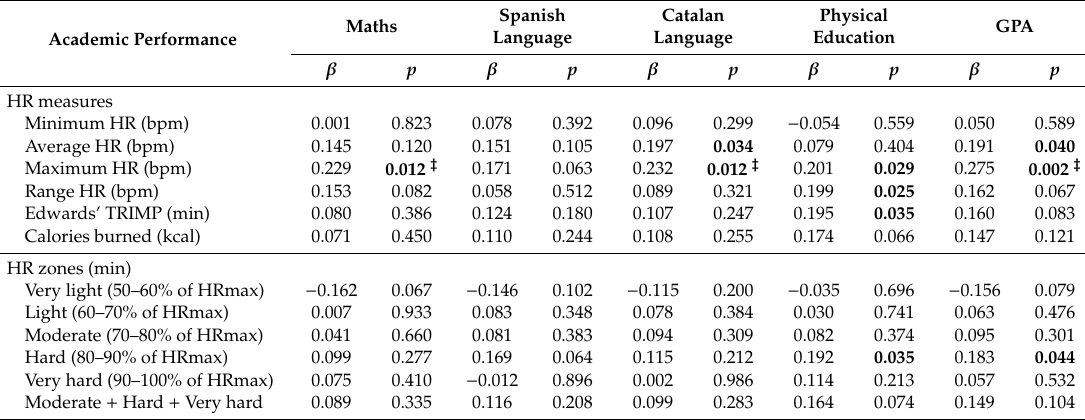
Table 3. Associations of HR measures with academic performance indicators ( n =